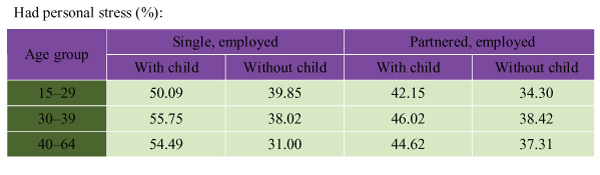
Percentage of Women Reporting High Personal Stress by Age Group, With and Without Children. Source: Statistics Canada, National Population Health Survey, 1994–1995